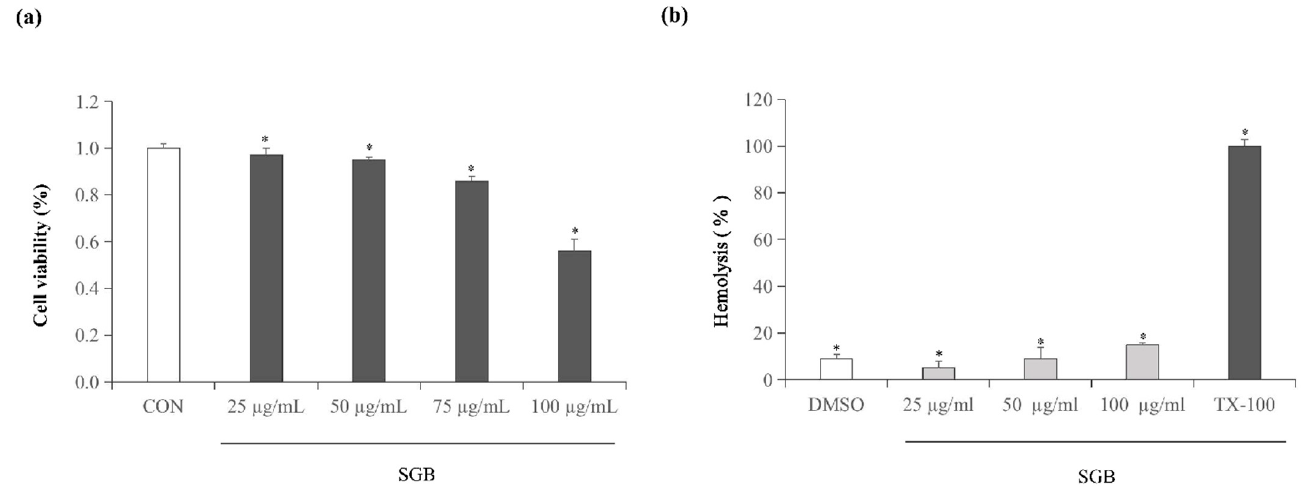
Figure 5. ( a ) Effects of SGB treatment on cytotoxicity in RAW 264.7 cells. Cell viability was evaluated using an MTS assay after 24 h treatment with SGB. ( b ) Hemolysis of SGB on rabbit blood cells. Triton X-100 (TX-100) was used as a positive control. Dimethyl sulfoxide (DMSO) was used as a negative control. The data are presented as the mean ± standard deviation of three independent experiments. * p < 0.05.